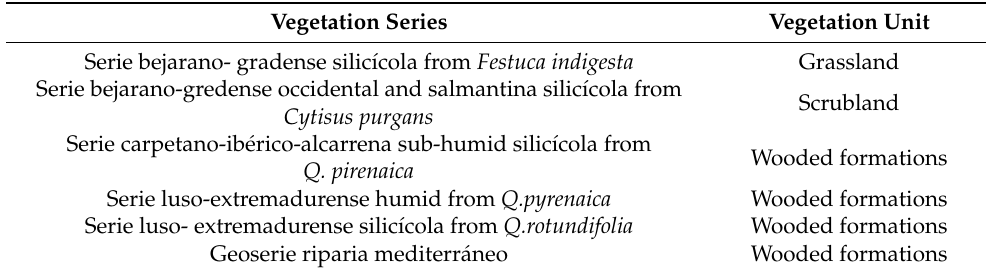
Table 1. Reclassification of the vegetation series to the legend of the vegetation mapping used for the study.